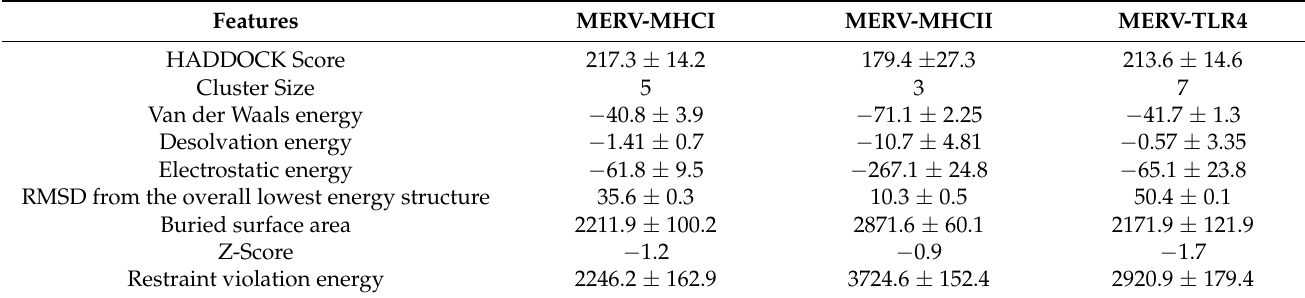
Table 9. Docking of vaccines with immune receptors and MHC